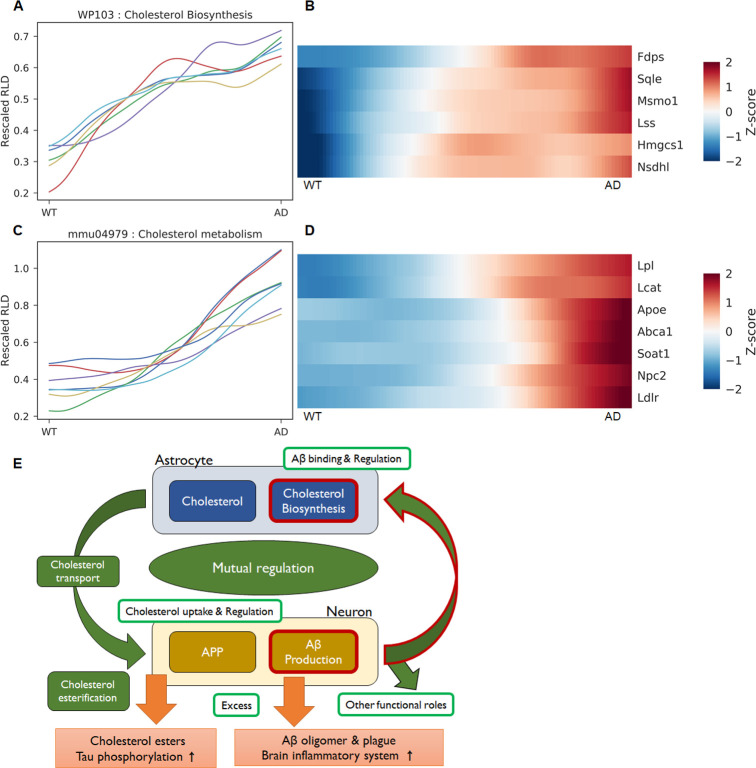
The transition curves and heatmap of genes related to cholesterol biosynthesis and cholesterol metabolism.(A-B) The transition curves of genes in the cholesterol biosynthesis pathway show very early increases and saturation. (C-D) Cholesterol metabolism, which is a KEGG pathway associated with cholesterol, shows a lower FDR value in P3 and a late increase of transition curves for genes such as Apoe, Abca1, and Ldlr. (E) Schematic diagram of a suggested hypothesis for mutual regulation between Aβ production and cholesterol biosynthesis. Our finding that Aβ regulates cholesterol biosynthesis is denoted by the red outlines. Other parts were constructed based on the referenced literature.